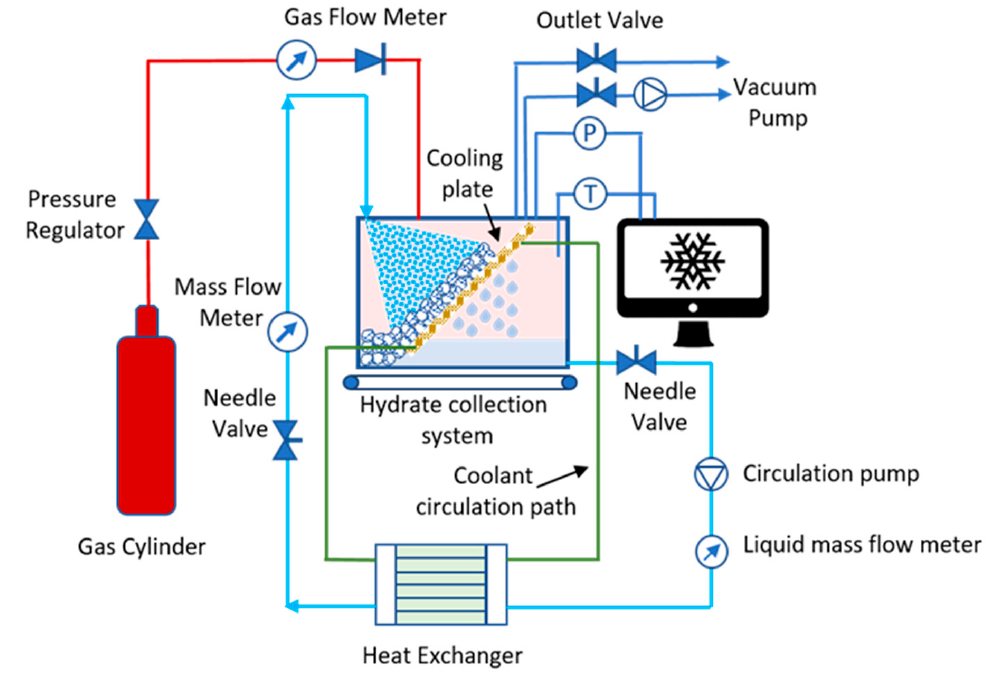
Figure 9. Experimental apparatus for water-spray design.